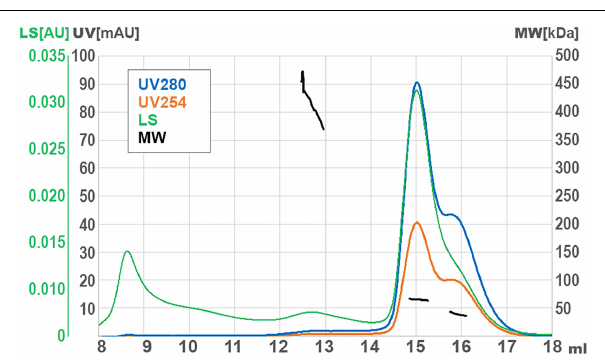
FIGURE 7 | Size exclusion chromatography (SEC) with multi-angle light scattering (MALS) analysis for GP46 F 13 . UV absorption and light scattering (LS) are shown on the left axis, molecular weight of protein (MW) are on the right axis. Short black lines mark the detected molecular mass.